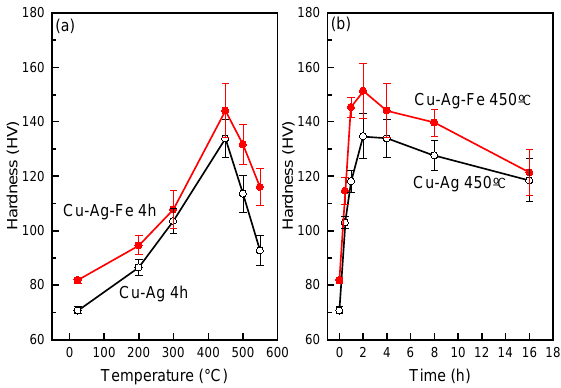
Figure 7. Hardness of aged alloys: ( a ) at different temperatures for 4 h, ( b ) at 450 °C for different times. Tensile tests for the Fe-free and Fe-doping alloys were carried out at room temperature on as-solid-solution and ageing-treated samples, as shown in Figure 8. The as-solid-solution samples exhibited very low tensile strength, yield strength and elongation, as shown in Table 2. For the Fe-free alloy, the tensile strength and yield strength were 180.4 MPa and 113.6 MPa, respectively. For Fe-doping alloy, the tensile strength and yield strength were 225.4 MPa and 126.1 MPa, respectively. The elongation for both alloys was 13.5% and 13.7%, respectively. Compared with the as-solid-solution samples, the tensile strength, yield strength and elongation of ageing-treated samples all increased after being aged at 450 ◦ C for 2 h. The tensile strength and yield strength were 260.3 MPa and 201.1 MPa for the Fe-free alloy. For the Fe-doping alloys, tensile strength and yield strength were 21.3% and 41.3% higher, respectively, than those of the Fe-free alloy, as also shown in Table 2. With the ageing temperature increasing up to 550 ◦ C, the tensile strength, yield strength and elongation of both alloys decreased. The tensile strength and yield strength of the Fe-free alloy decreased to 224.7 MPa and 187.3 MPa. For the Fe-doping alloy, the tensile strength and yield strength decreased to 293.6 MPa and 252.2 MPa, which is 30.7% and 34.7% higher, respectively, than those of the Fe-free alloy. The apparent decrease of tensile strength and yield strength for the Fe-free alloy was due to the Ag dissolved into the Cu matrix, which weakened the precipitation hardening of Ag precipitates. However, the few decreases of tensile strength and yield strength for the Fe-doping alloy were a result of the precipitation of Fe precipitates out of the Cu matrix, which caused the precipitation